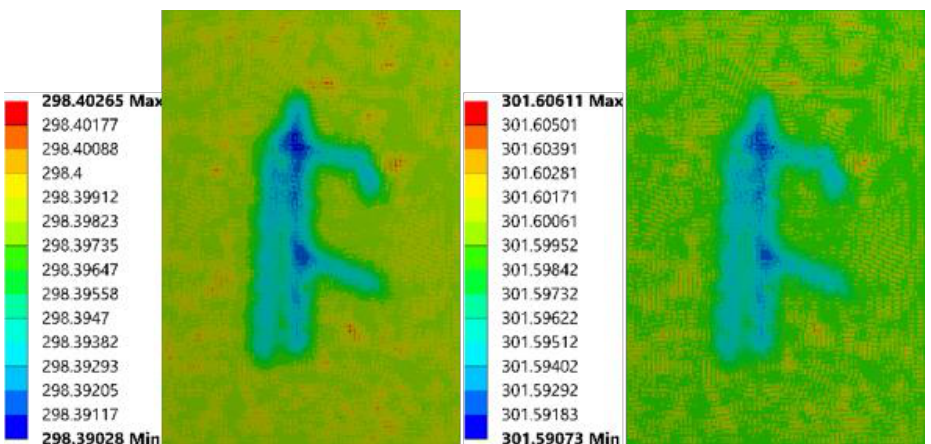
Figure 7. Simulation images of FEA model with 20 s ( left ) and 30 s ( right ) heating time.